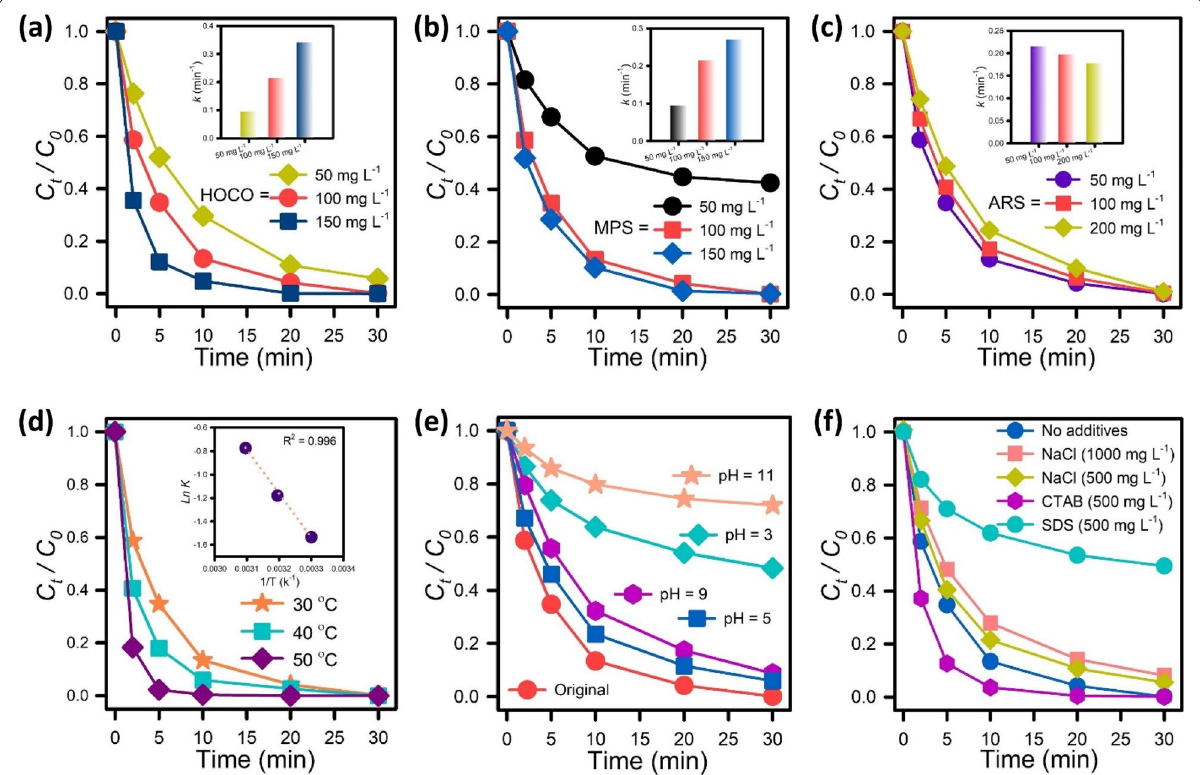
Fig. 5b. The corresponding k value at 50 mg L − 1 of